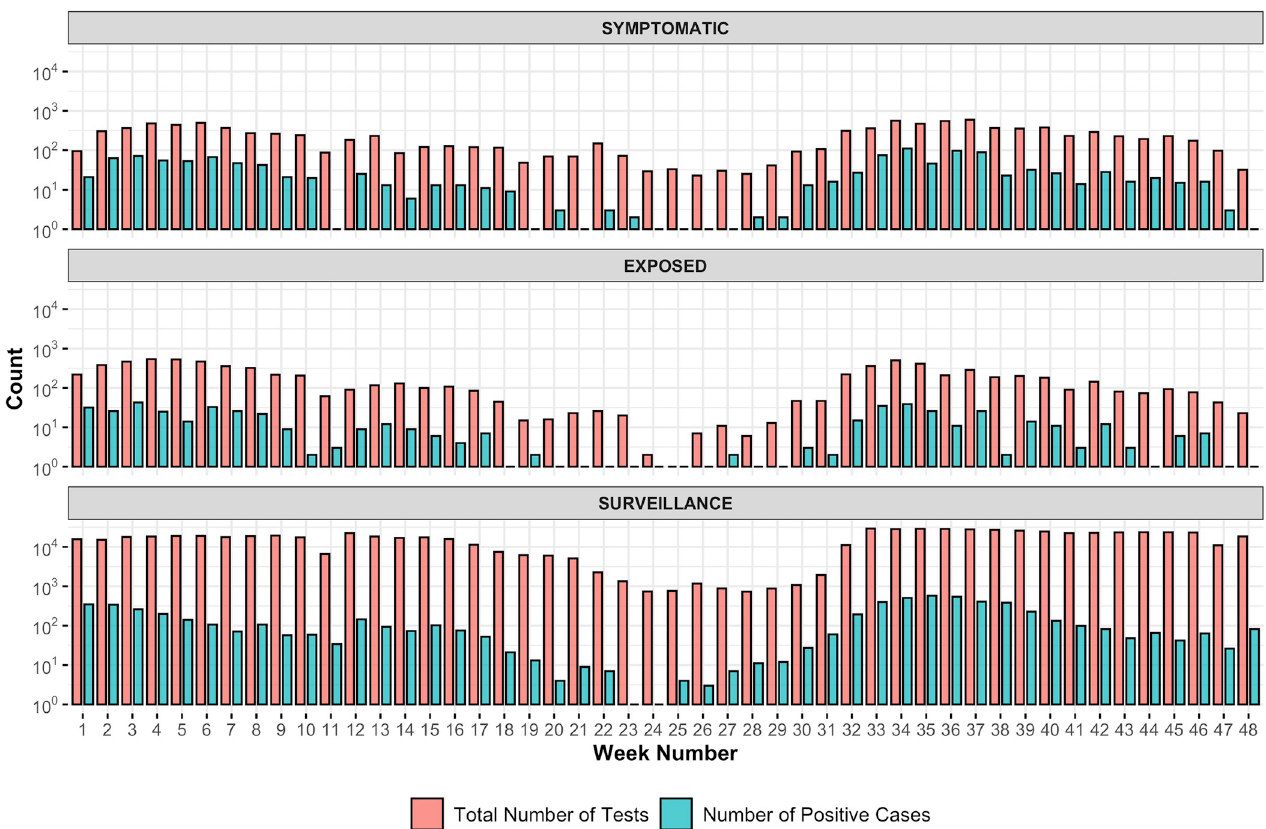
Fig 3. Number of tests and positive tests per category, by week. Note that the y-axis is on a log10 scale. Samples are labeled “symptomatic” if the patient reports symptoms at the time of testing, or labeled “exposed” if they report exposure to a positive patient. Surveillance samples represent the rest of the samples collected. The lower case load during week 11 is due to the university’s spring break, and weeks 18–29 account for summer break.